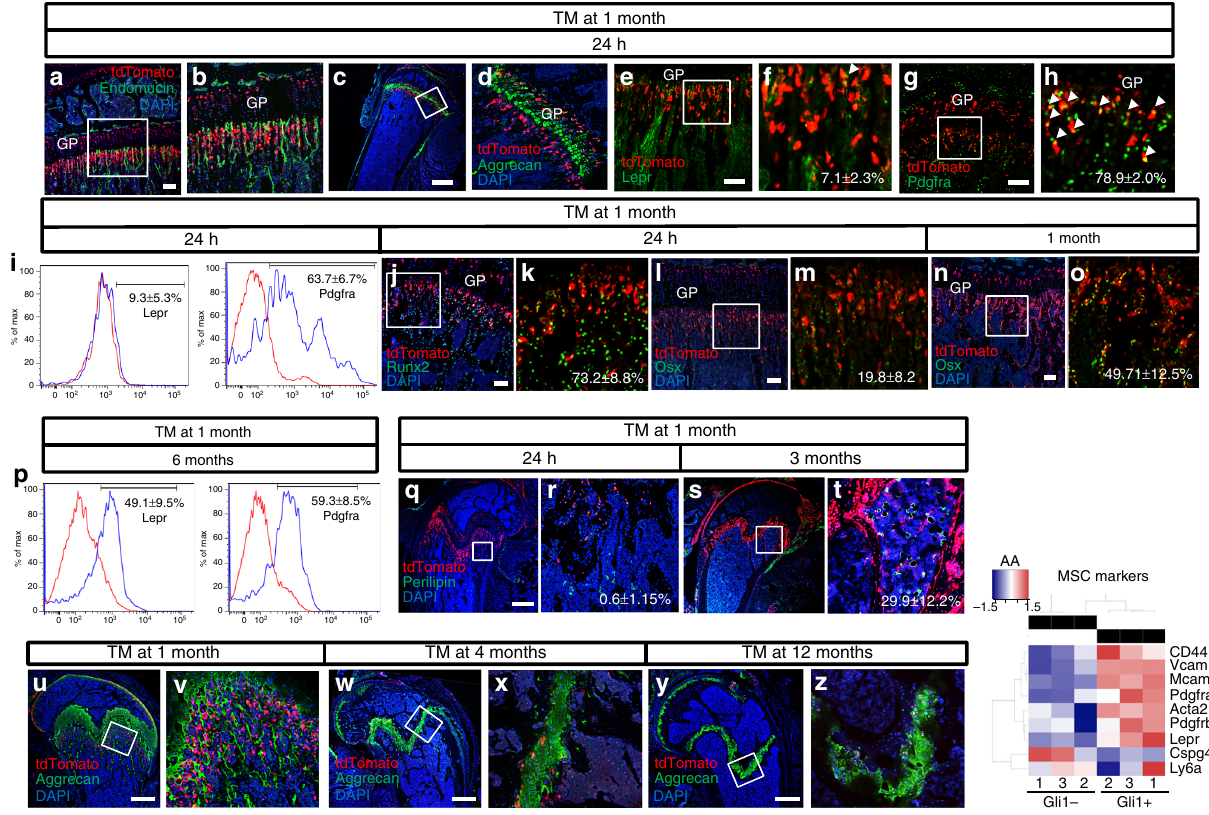
Fig. 4 Gli1 marks MMPs in postnatal growing mice. a – f Confocal images of immuno fl uorescence staining for Endomucin a , b , Aggrecan c , d , or Lepr e , f on frozen sections of the proximal tibia. Boxed areas shown in magni fi ed images to the right. GP growth plate. Arrowhead in f denotes a typical Lepr + tdTomato + cell. Percentage (mean ± SD, n = 3) of double positive cells over total tdTomato + cells was calculated from cancellous bone region extending 300 µ m from growth plate in two sections each of three mice. Same below. Scale bars: 100 µ m ( a , e ) or 500 µ m c . g , h Confocal images of direct fl uorescence on frozen sections of proximal tibia. Boxed area shown at a higher magni fi cation to the right. Arrowheads in h denote Pdgfra + tdTomato + cells. Scale bar: 100 µ m g . i FACS analyses of Lepr (left) or Pdgfra (right) expression among CD31 − CD45 − Ter119 − tdTomato + cells from the cancellous bone region beneath the growth plate of either distal femur or proximal tibia. Red and blue lines represent control IgG and speci fi c antibody, respectively. j – o Confocal images of Runx2 j , k or Osx l – o immuno fl uorescence staining on frozen sections of the proximal tibia. Boxed areas are shown in magni fi ed images to the right k , m , o . DAPI signal was omitted in k , m , o for better visualization. Scale bar: 100 µ m. p FACS analyses of Lepr (left) or Pdgfra (right) expression among CD31 − CD45 − Ter119 − tdTomato + from the bone marrow. Red and blue lines represent the control and speci fi c antibody, respectively. Quanti fi cation is presented as mean ± SD, n = 3. q – t Confocal images of immuno fl uorescence staining for perilipin on frozen sections of distal femur. Boxed areas are shown at higher magni fi cation to the right. Percentage (mean ± SD, n = 3) of perilipin + tdTomato + over perilipin + adipocytes was acquired from cancellous bone region extending 400 µ m from the growth plate in two sections each of three mice. Scale bar: 500 µ m. u – z Confocal images showing Gli1 + cells (red) and immuno fl uorescence signal of Aggrecan (green) in distal femur of Gli1-CreER T2 ;Ai9 mice treated with TM at different ages and harvested after 24 h. Scale bar: 500 µ m. Boxed areas are shown at higher magni fi cation to the right v , x , z . (AA) Differential expression of MSC marker genes in Gli1 + MMPs vs. Gli1 − mesenchymal cells. Heatmap generated from RNA-seq data of three paired biological replicates. Scale derived from voom-transformed data indicating relative increase (red) or decrease (blue) in